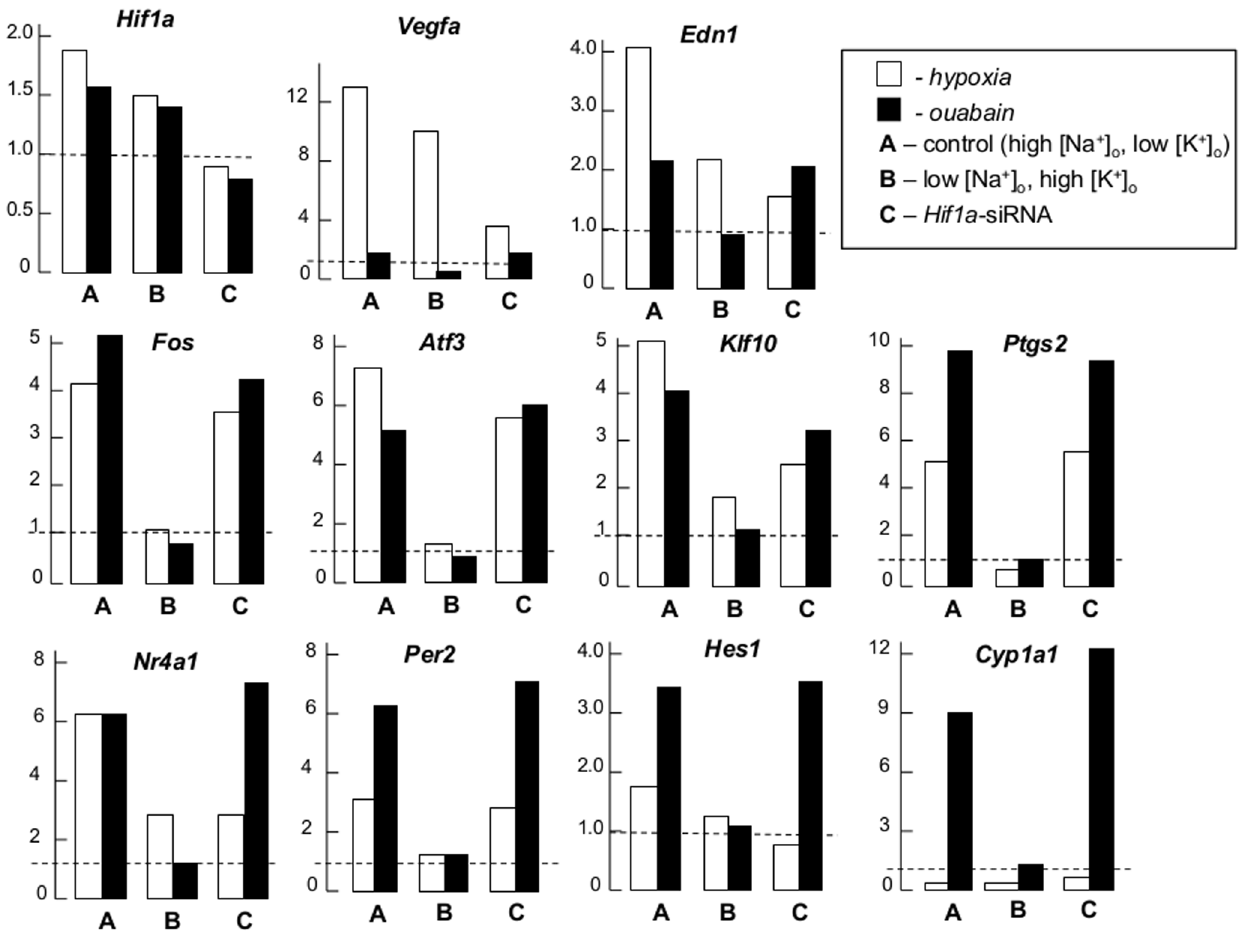
Figure 7. Effect of hypoxia and ouabain on gene expression in RASMC. Cells were exposed to normoxia, hypoxia/glucose deprivation or 3 mM ouabain for 24 hr in control high-Na + , low-K + medium ( A, C ), or high-K + , low-Na + medium ( B ). In some experiments, RASMC were transfected with Hif-1 a siRNA ( C ). mRNA content in normoxia was taken as 1.00 and shown by broken lines. For more details, see figure 4 legend.